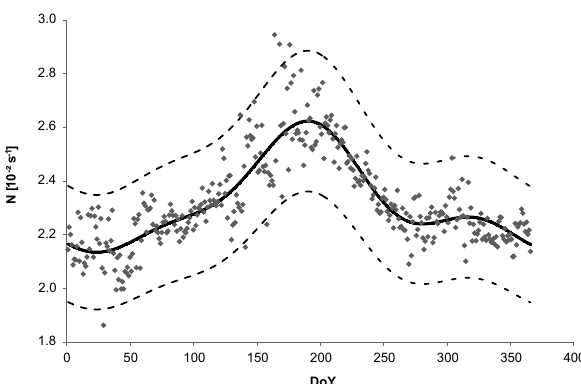
Figure 4. The temperature gradient based on CIRA-86 data for 45 ◦ N between 83 and 90km height is negative during the whole year. The steepest gradient is reached in March and September (ca. 20K/7km); it differs least from zero in summer (June–July, ca. 10K/7km). The temperature values are offset by + 30K per month for all months except